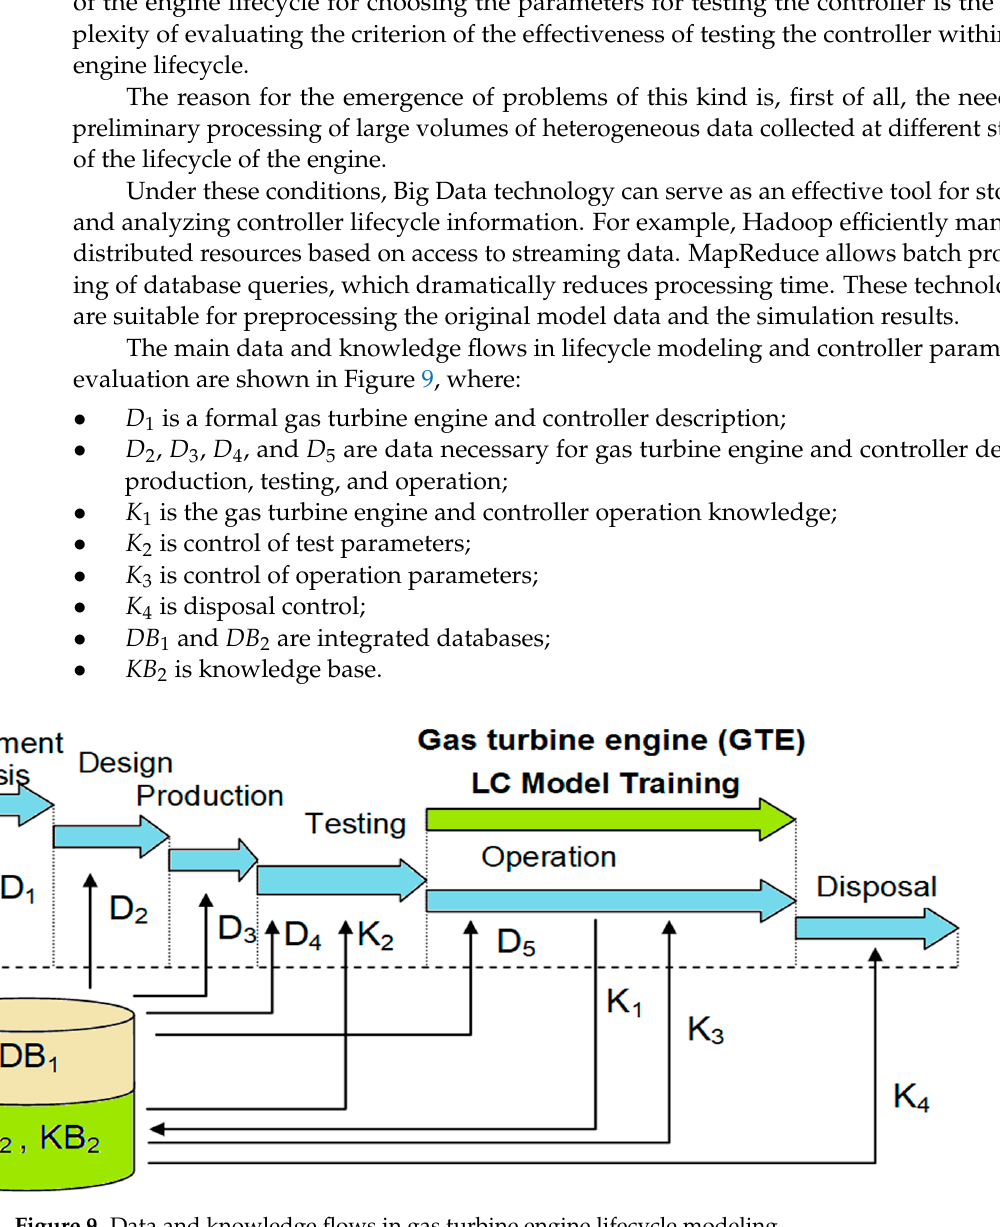
Figure 9. Data and knowledge flows in gas turbine engine lifecycle modeling. Thus, the information obtained at the testing stage can be used to optimize the per- formance of the nonlinear controller. However, the design stage of a nonlinear controller presented above is a rather important stage, since it allows for developing a prototype, tak- ing into account the constraints, which ensure the optimization of costs for the development of the entire control